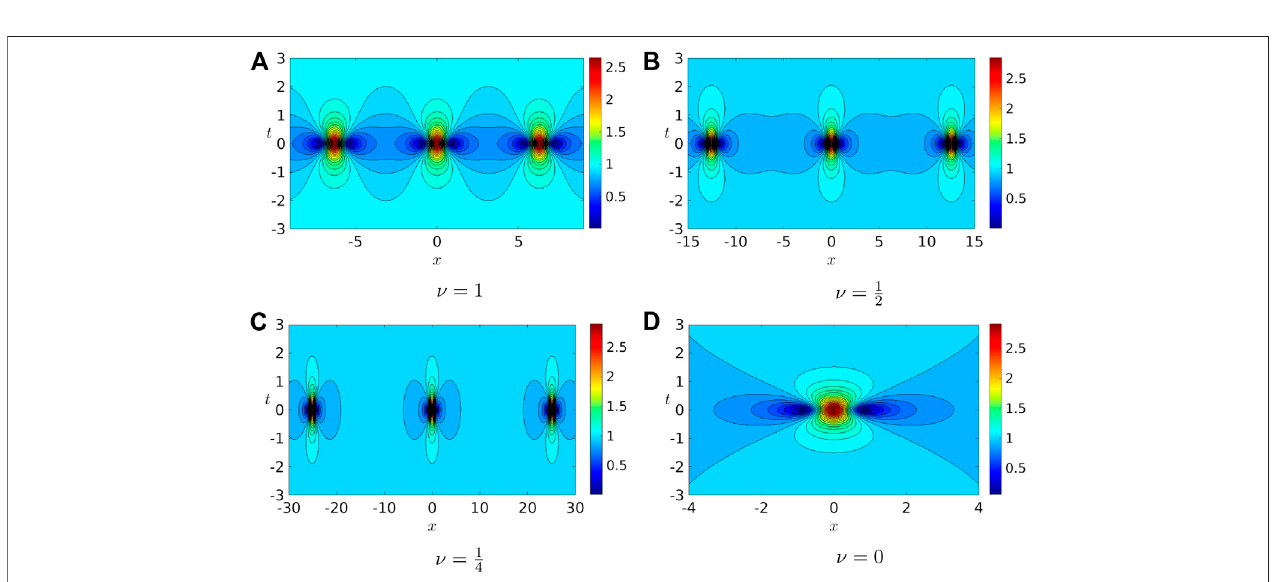
FIGURE 3 | Contour plots for the moduli of the Akhmediev breather for (A) ] (cid:2) 1, (B) ] (cid:2) 0 . 5, and (C) ] (cid:2) 0 . 25, as well as (D) the Peregrine soliton.